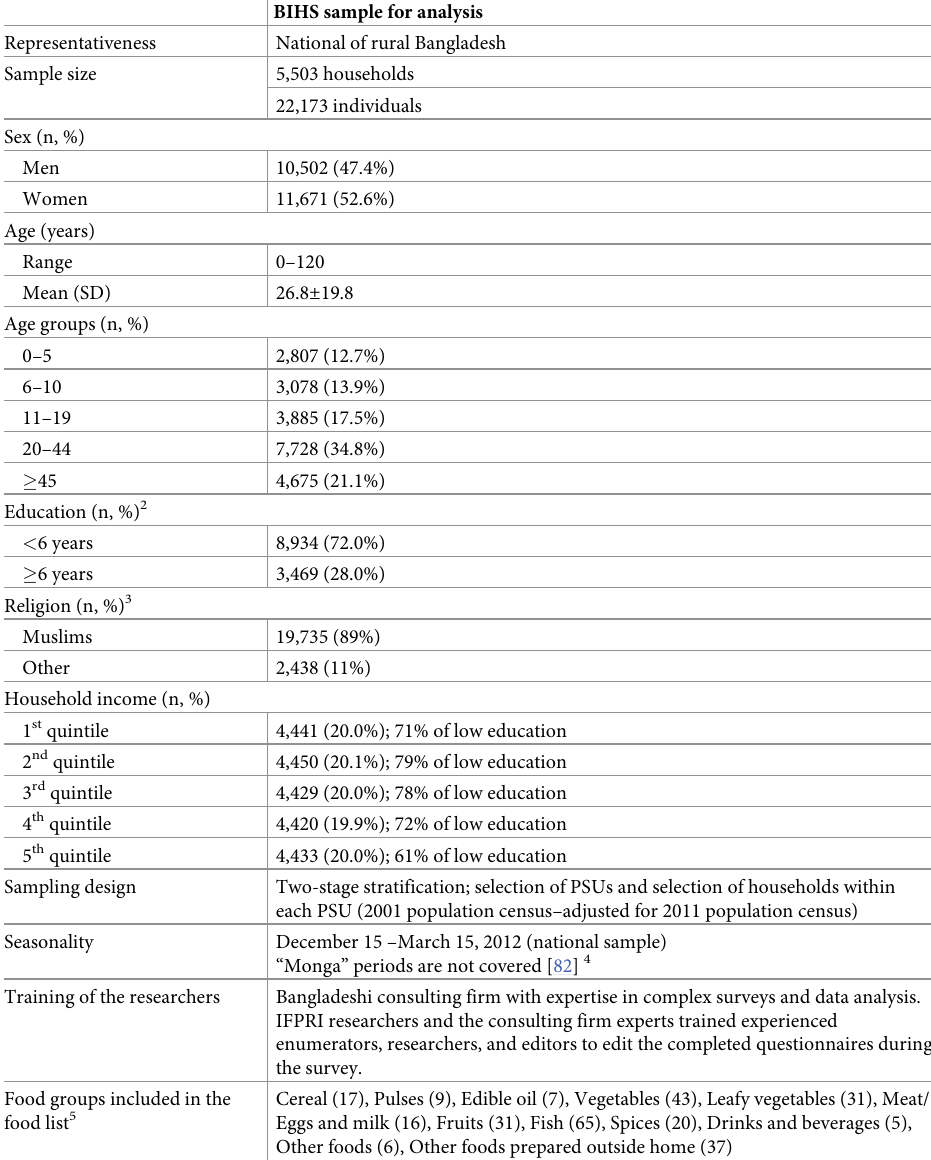
Table 1. Characteristics of the 2011–2012 Bangladesh Integrated Household Survey (BIHS) 1